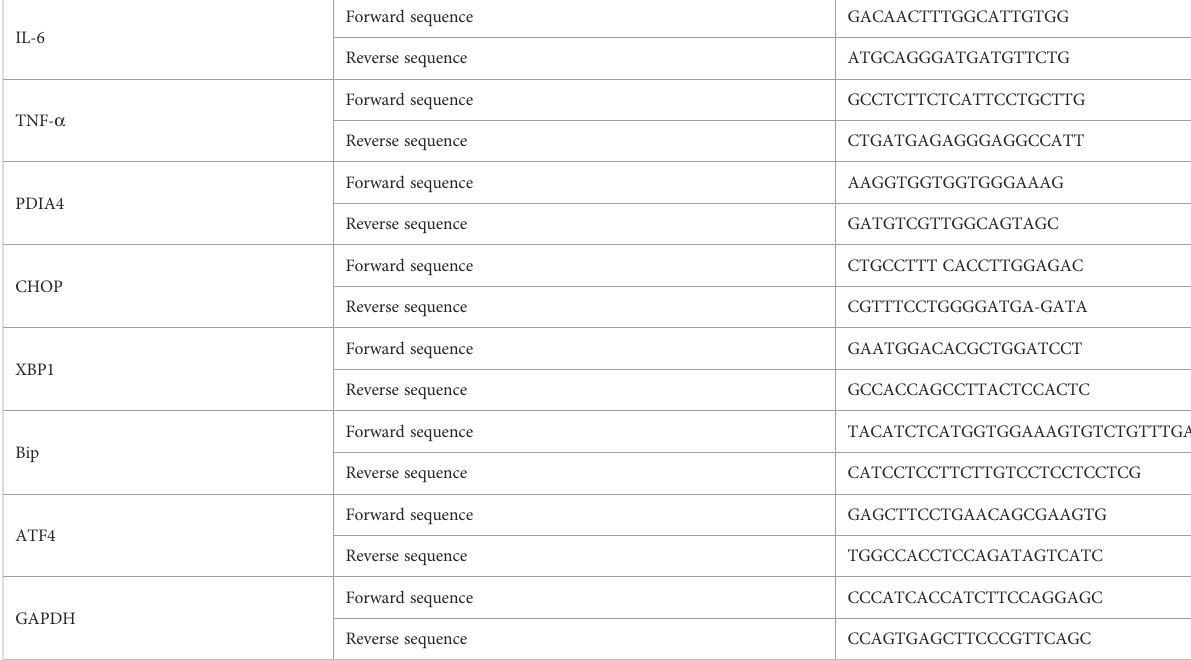
TABLE 1 Primer sequences used for real time RT-PCR.